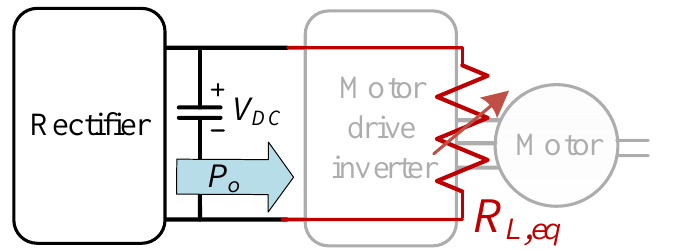
Figure 2. Equivalent load seen from the DC‑link. Voltage Limitation of Field Oriented Control